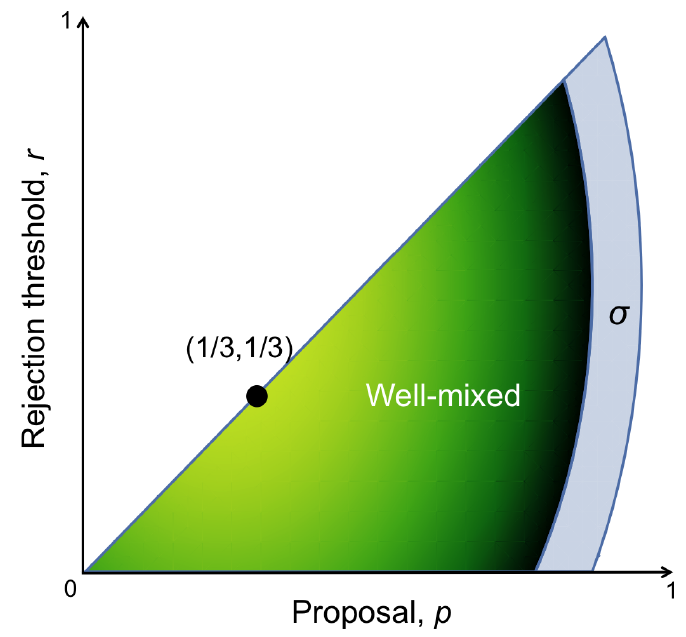
Figure 1. Structure increases the region of strategies that are selected for: light blue region gets added to the yellow-green gradient region corresponding to a well-mixed population. = 1 . 5 ; here the optimum strategy remains the Results are shown for weak selection with σ 0 same (1 / 3 , 1 / 3)